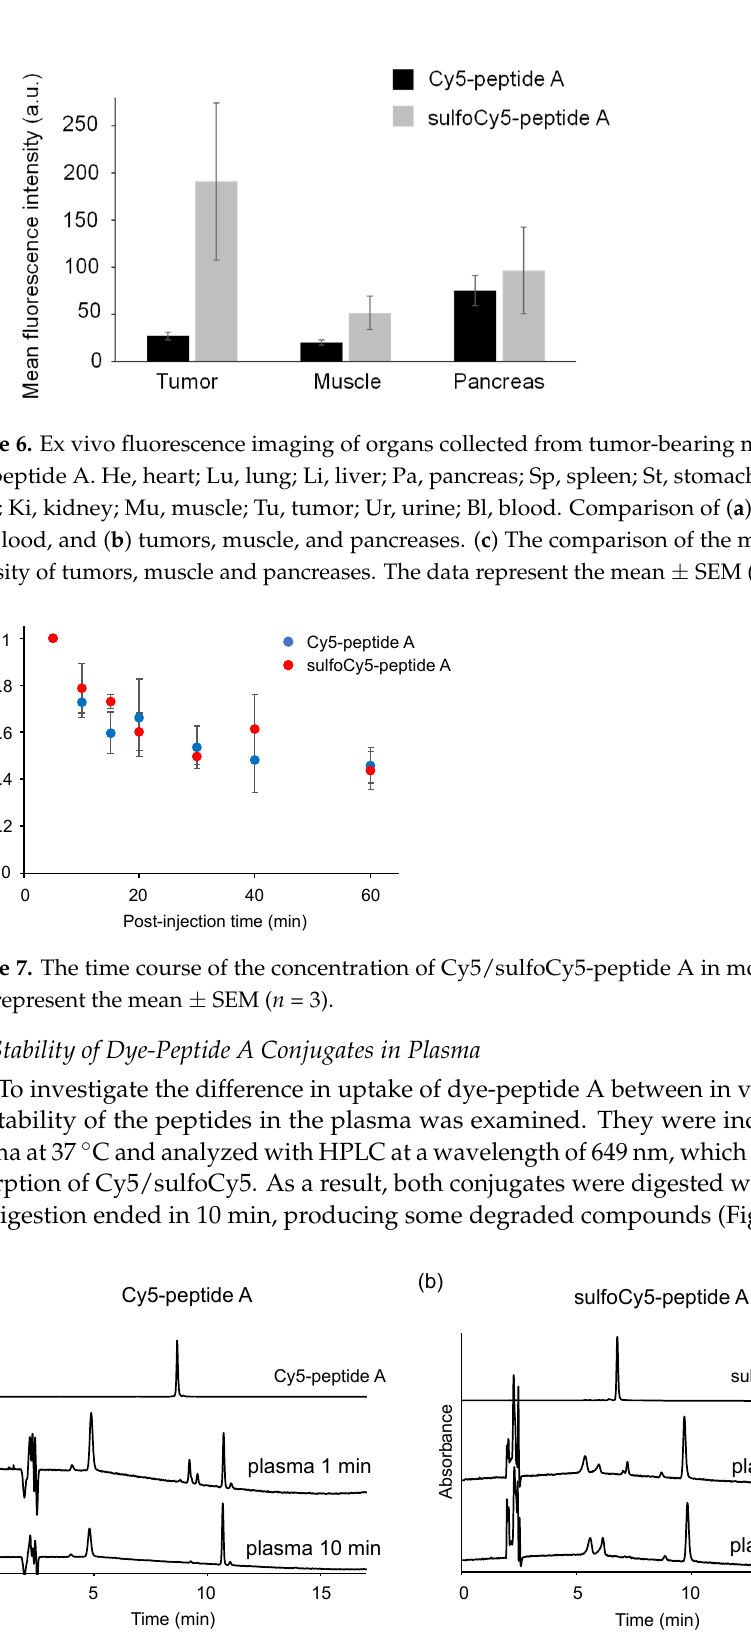
Figure 8. Stability of dye-peptide A in mice plasma. ( a ) 1 μ M Cy5-peptide A and ( b ) 1 μ M sulfoCy5-peptide A were dissolved in the plasma. The plasma containing dye-peptide A was incubated at 37 °C for 1 min or 10 min.